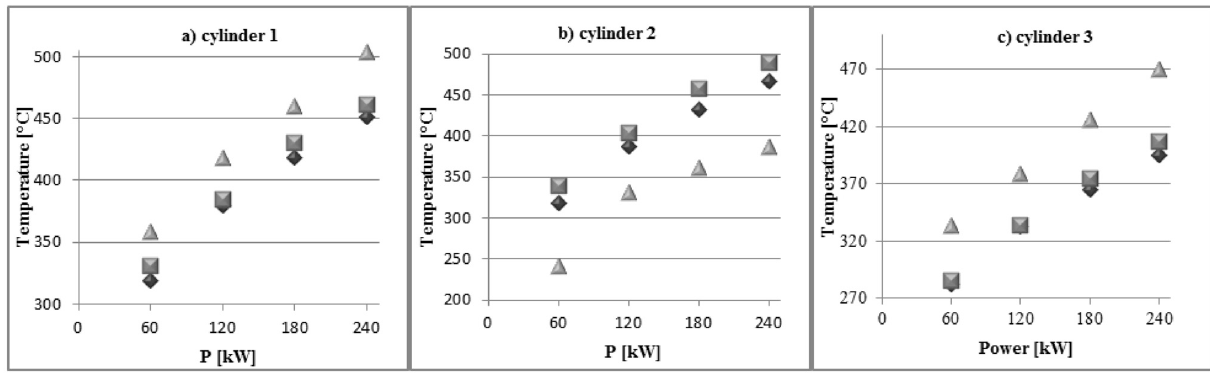
, b) CO, c) CO emissions: – engine assumed as operated without malfunctions, – the delay of the fuel x 2 injection, – the leakage of the fuel pump